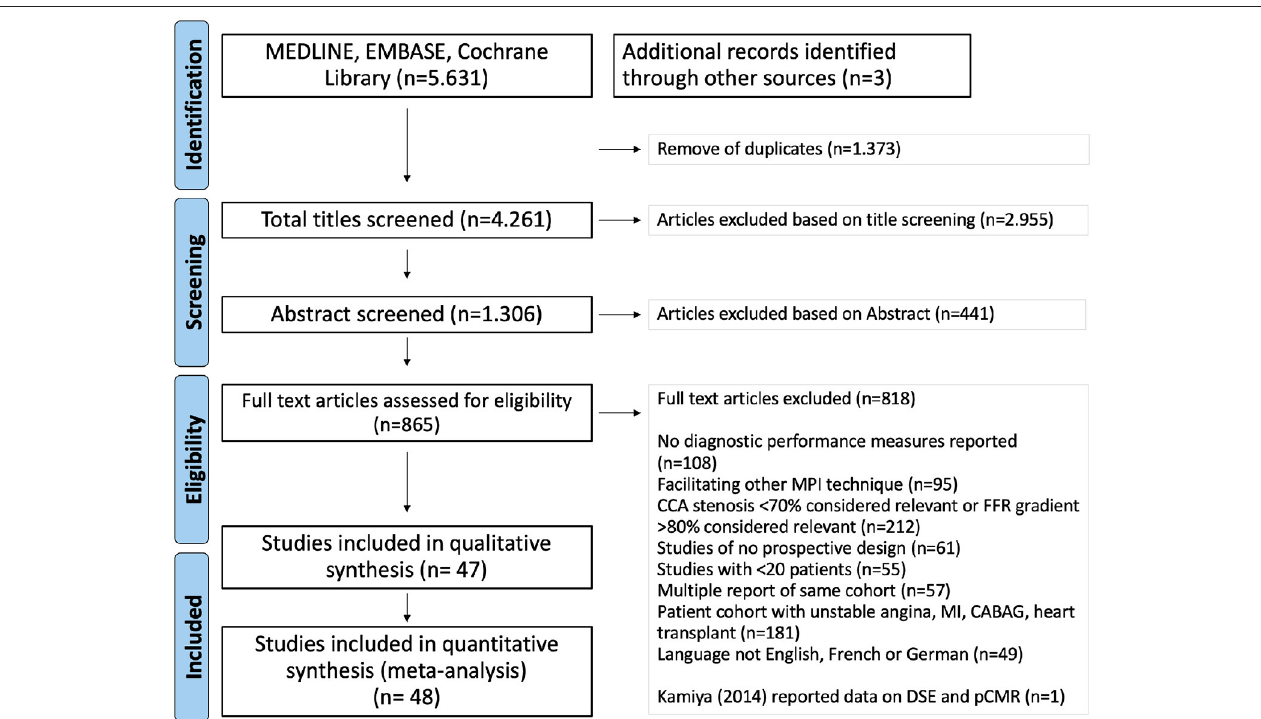
FIGURE 1 | Flowchart of study selection process. Kamiya et al. (18) reported results for DSE and pCMR, so that it contributed with two sets of data to the quantitative, but only once to the qualitative assessment.